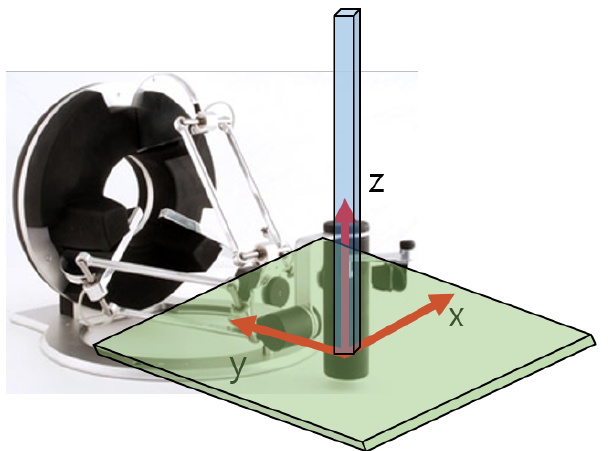
Figure 3. The generation of virtual walls that can only be manipulated in the x–y plane (green cuboid) or the z-axis (blue